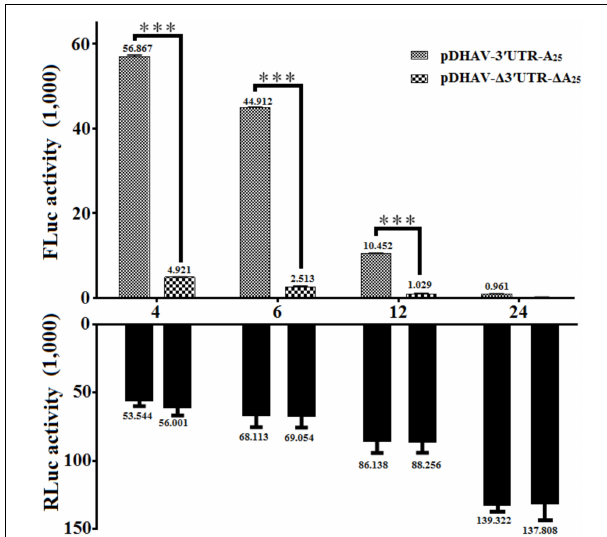
FIGURE 5 | The effect of the DHAV-1 3 (cid:48) UTR plus the poly(A) 25 tail on IRES-mediated translation efficiency. 0.8 µ g of of the in vitro transcribed products of the linearized plasmids pDHAV-3 (cid:48) UTR-A 25 and pDHAV- (cid:49) 3 (cid:48) UTR- (cid:49) A 25 were co-transfected into DEFs with 0.1 µ g of pGMLR-TK plasmid, and the FLuc/RLuc activities were measured from 4 to 12 hpt. Columns and bars represent the means and standard deviations, respectively, of three independent transfections. ∗ P < 0.05; ∗∗∗ P <